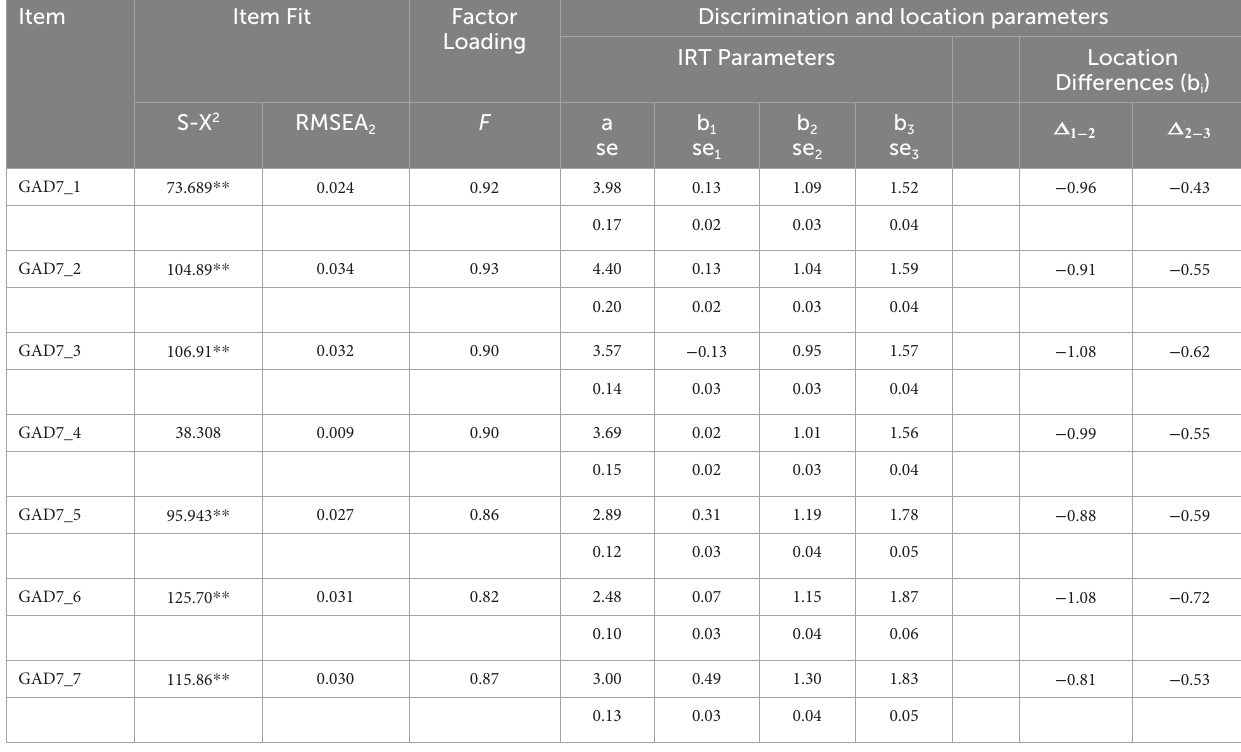
TABLE 4 Parámetros de los ítems, con graded response model (discrimination and location). Item